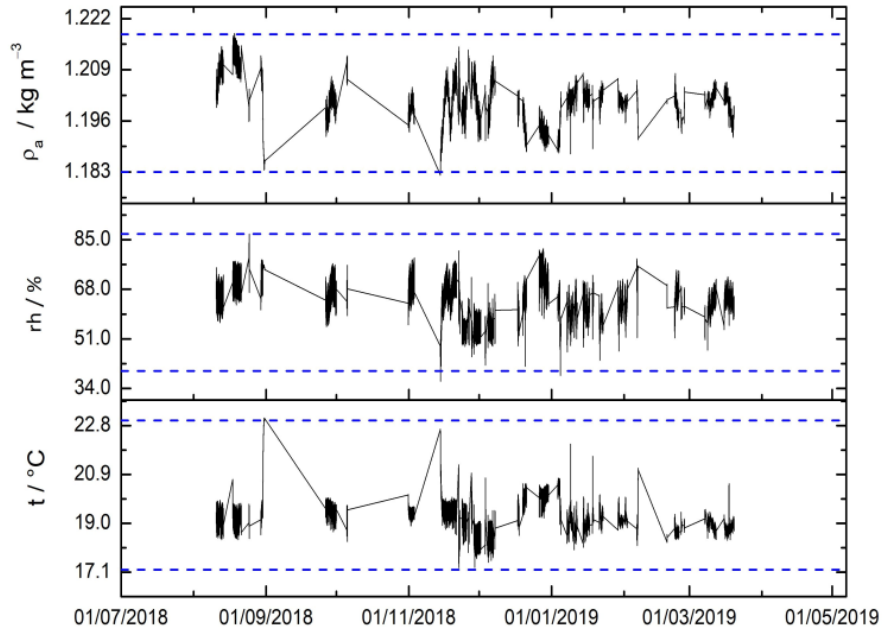
Figure 5. Variation range of environmental